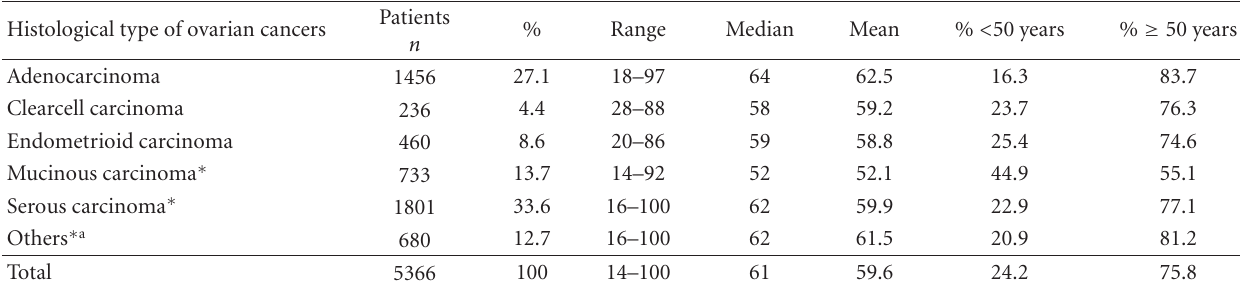
(a) All epithelial ovarian cancers according to histological type and age at diagnosis. Histological type of ovarian cancers